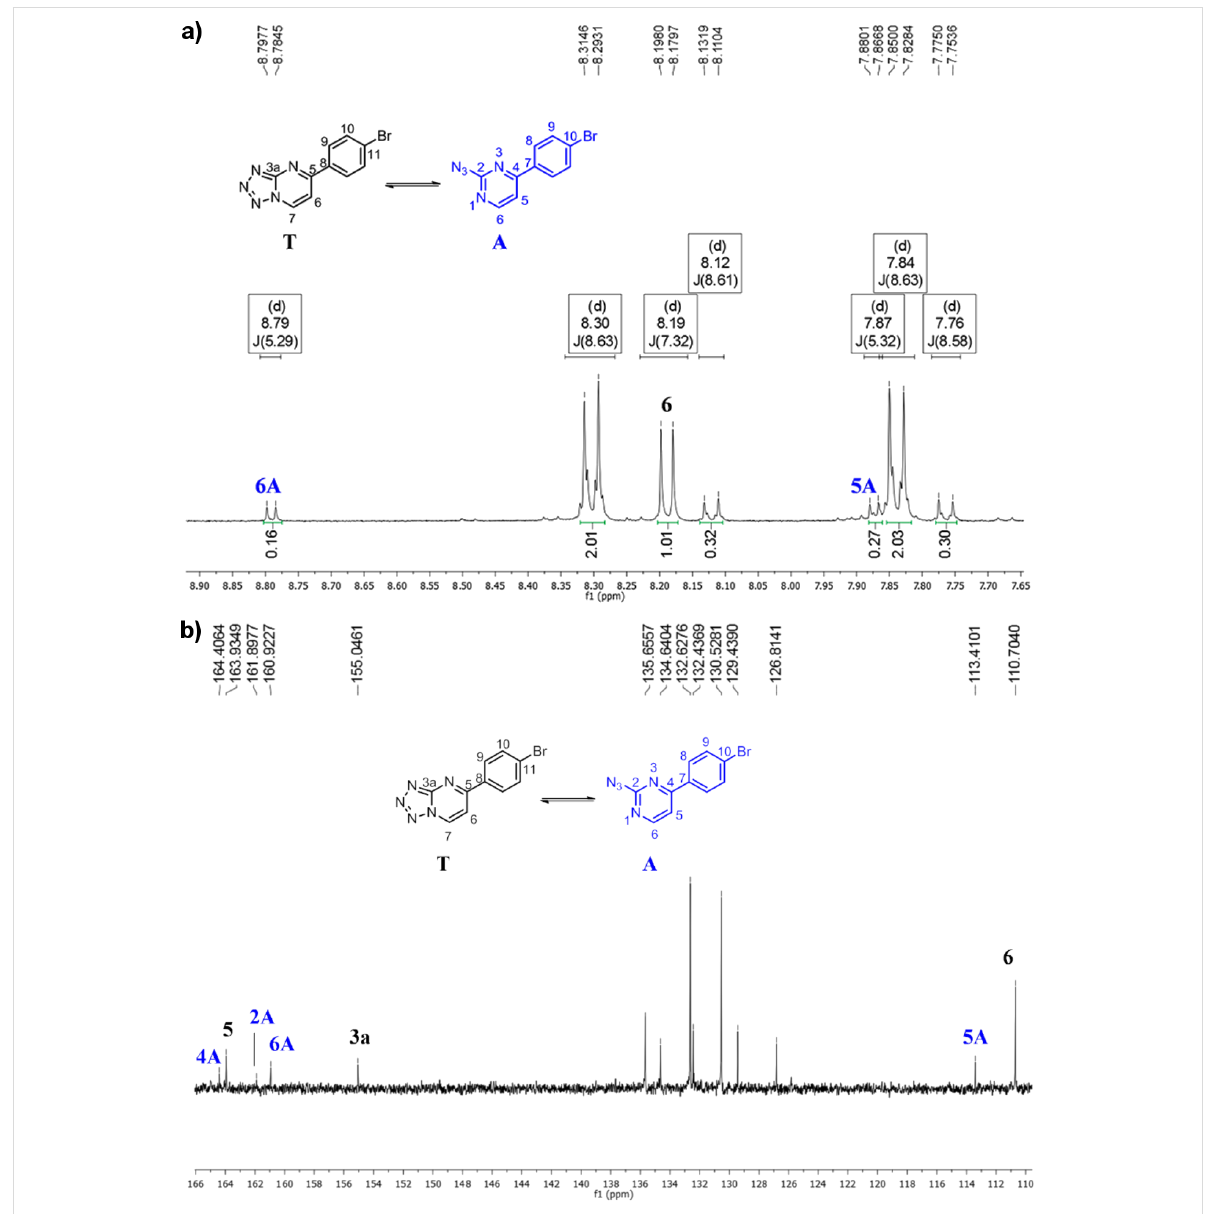
Figure 3: (a) 1 H and (b) 13 C NMR spectra demonstrating the 3d 4d equilibrium in DMSO- d 6 at 25